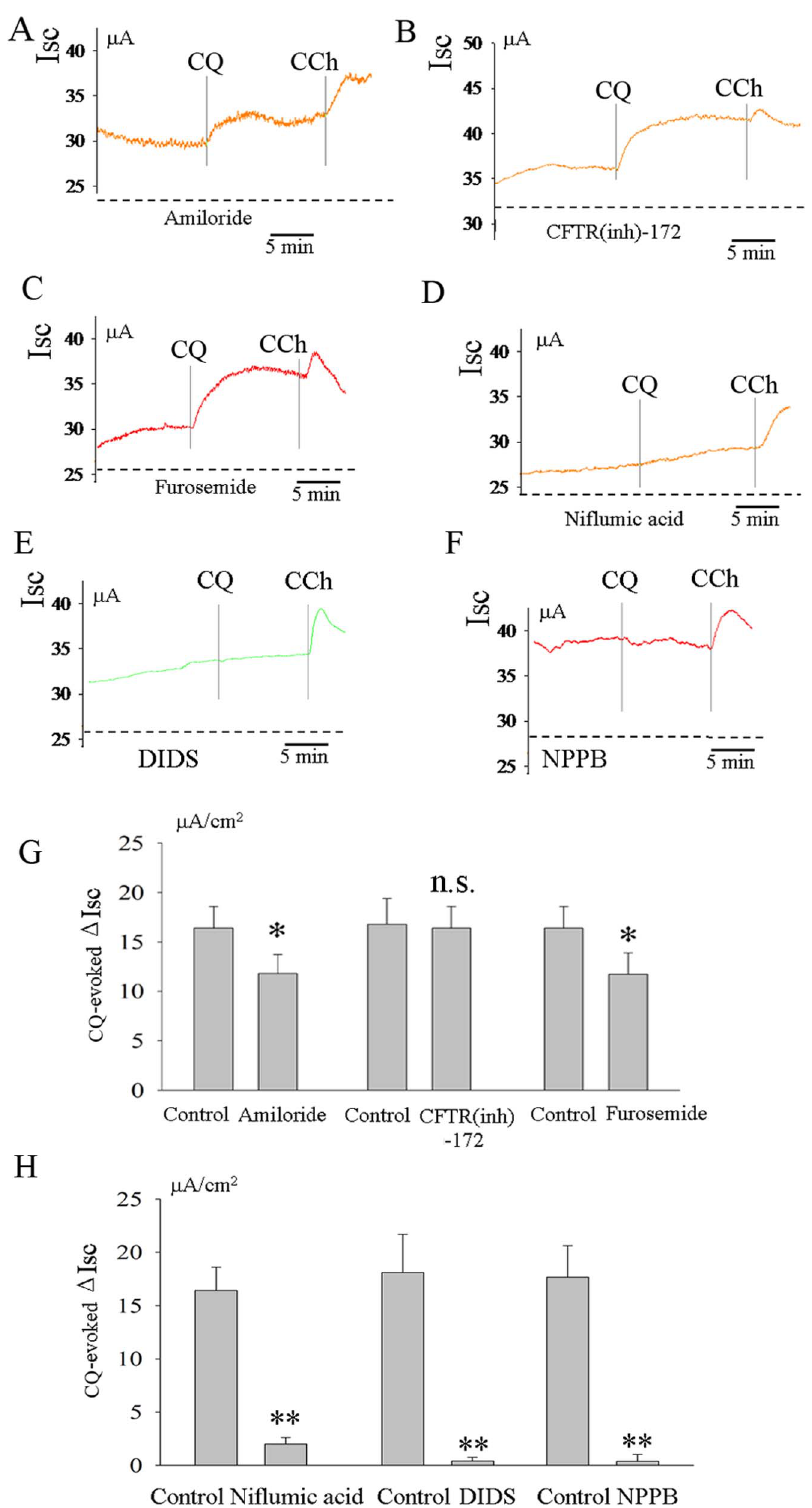
Figure 2. Effects of amiloride, CFTR(inh)-172, niflumic acid and furosemide on CQ-evoked increase in I SC in rat ileum. The CQ-evoked increase in I SC was partly inhibited by a blocker of epithelial Na + channels, amiloride(10 2 4 M)(n=7, A and G). Cl 2 channel inhibitor CFTR(inh)- 172(10 2 5 M) did not affect this CQ-evoked response (n=5,B and G) . An inhibitor of Na + -K + -2Cl 2 cotransporter, furosemide (10 2 4 M) also reduced the CQ-evoked increase in I SC (n=4, C and G). Niflumic acid (10 2 4 M), DIDS and NPPB almost completely abolished the CQ-evoked increase in Isc(n=9, D-F and H). * P , 0.05; ** P , 0.01;n.s: no significance by unpaired t -test.